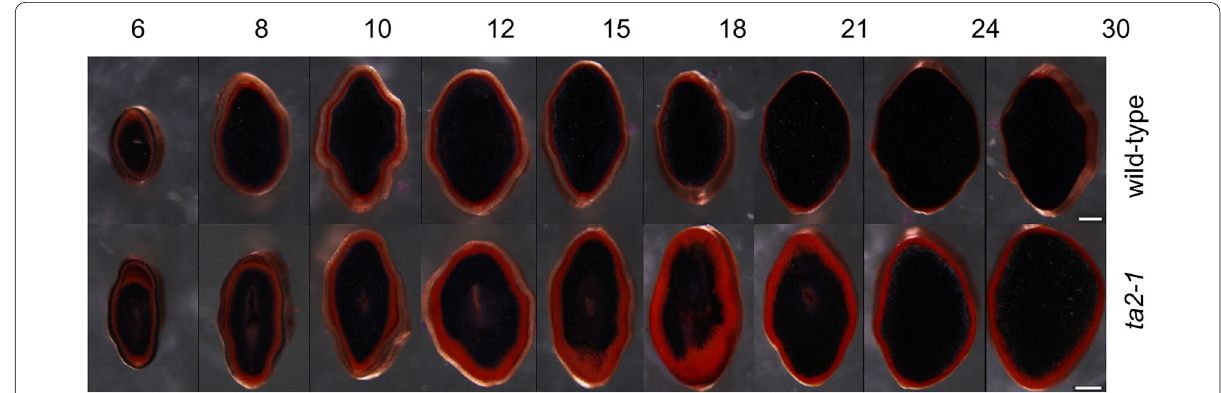
Fig. 1 Sudan red and Lugol’s iodine staining showing the overall lipid and starch organization of rice caryopsis during seed development. Upper panel indicates the wild‑type while lower panel indicates ta2-1 at 6, 8, 10, 12, 15, 18, 21, 24, and 30DAA. Scale bar